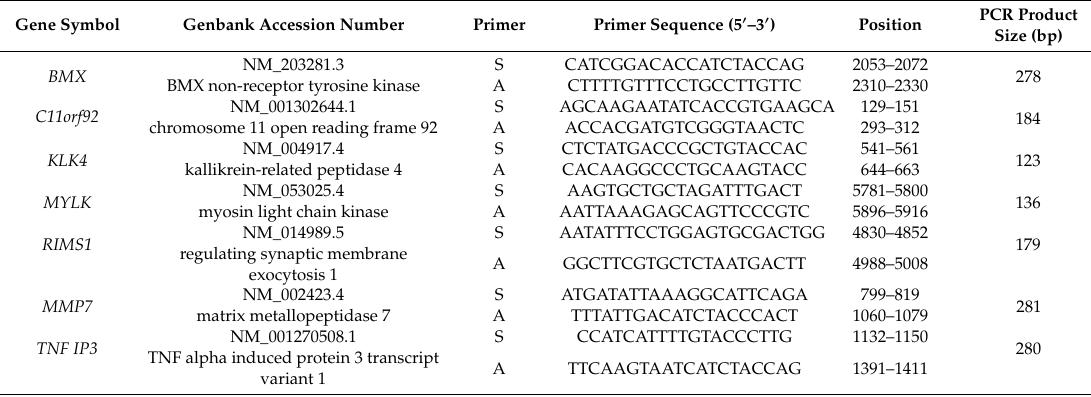
Table 2. Oligonucleotide sequences of sense (S) and antisense (A) primers. Gene